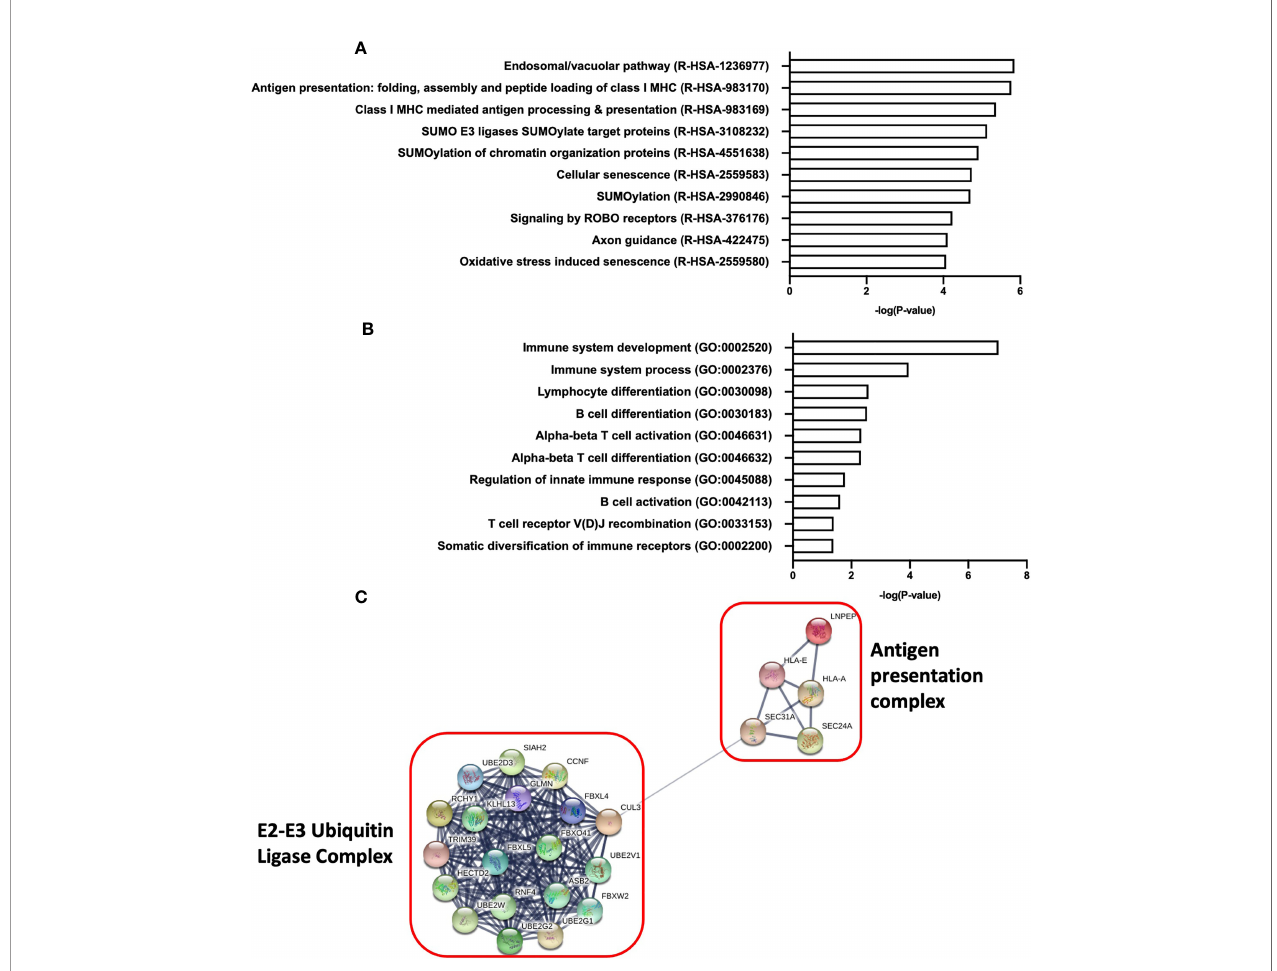
FIGURE 7 | Pathway analysis of miR-218-5p target genes reveal enrichment of pathways involved in immune development and T cell activation. (A) Reactome pathway analysis of top 10 of enriched pathways from miR-218-5p target genes. (B) Biological processes (Gene Ontology) analysis of pathways involved in immune system development and regulation from miR-218-5p target genes. (C) Network analysis of proteins involved in Class I MHC antigen presentation and processing as determined by Reactome analysis. An adjusted p-value ≤ 0.05 was used as a threshold to select signi fi cant terms and